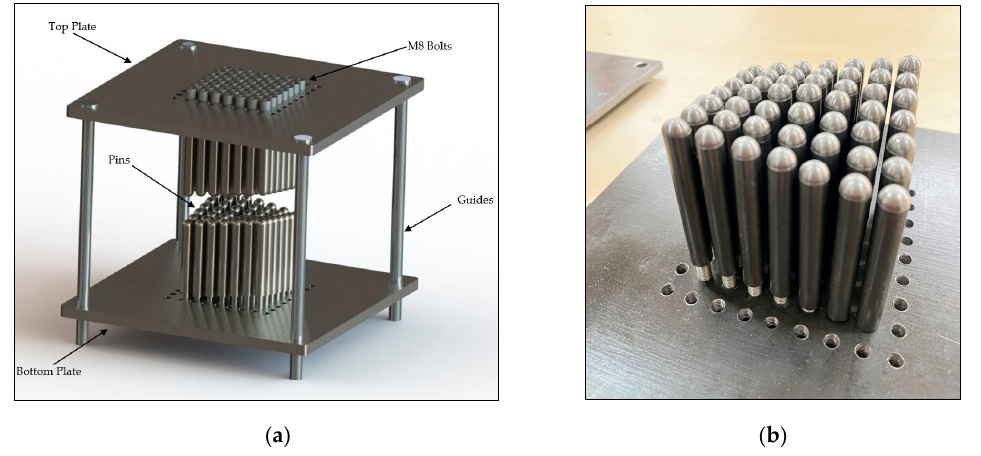
Figure 1. Representation of ( a ) die set; ( b ) Constructed bottom die.